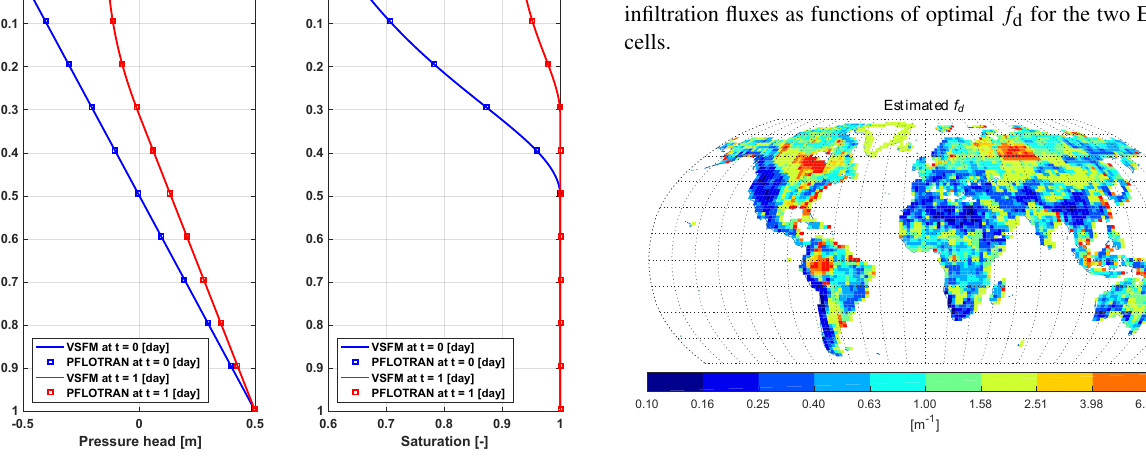
Figure 5. Global estimate of f d . Eq. (20; Fig. 4a and b). For 0 . 1 ≤ f d ≤ 1, the slope of the WTD– f d relationship for all grid cells is log–log linear with a slope of − 1 . 0 ± 0 . 1. The log–log linear relationship breaks down for f d > 1, where the drainage flux becomes much smaller than infiltration and evapotranspiration (Fig. 4c and d). Thus, at larger f d , the steady state z ∇ becomes indepen- dent of f d and is determined by the balance of infiltration and evapotranspiration. For 79 % of the global grid cells, the ensemble range of simulated WTD spanned the F2013 dataset. The optimal value of f d for each of these grid cells was obtained by linear interpolation in the log–log space (e.g., Fig. 4a). For the remaining 21 % of grid cells where the shallowest sim- ulated WTD across the range of f d was deeper than that in the F2013 dataset, the optimal f d value was chosen as